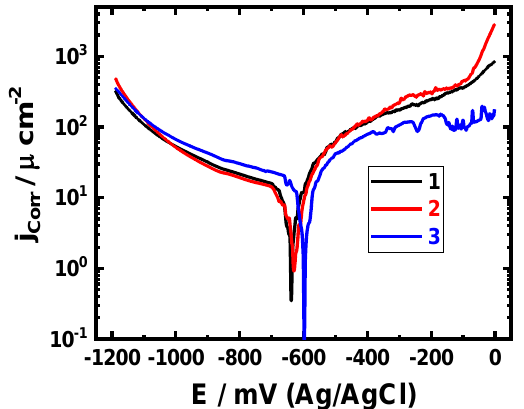
Figure 21. Potentiodynamic polarization curves obtained for (1) Base metal, (2) TIG, and (3) ATIG. after 1 h immersion in the 3.5% NaCl solutions.